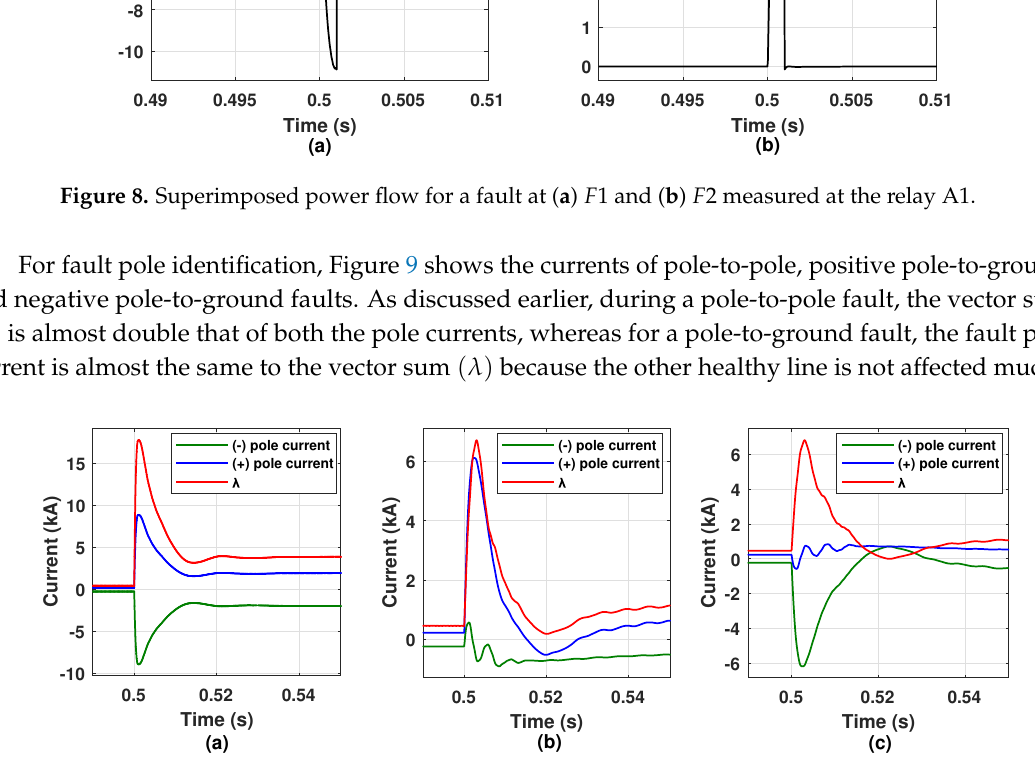
Figure 9. The positive pole current, negative pole current, and the vector sum ( λ ) for a ( a ) Pole-to-pole fault; ( b ) positive pole-to-ground fault; ( c ) negative pole-to-ground fault.